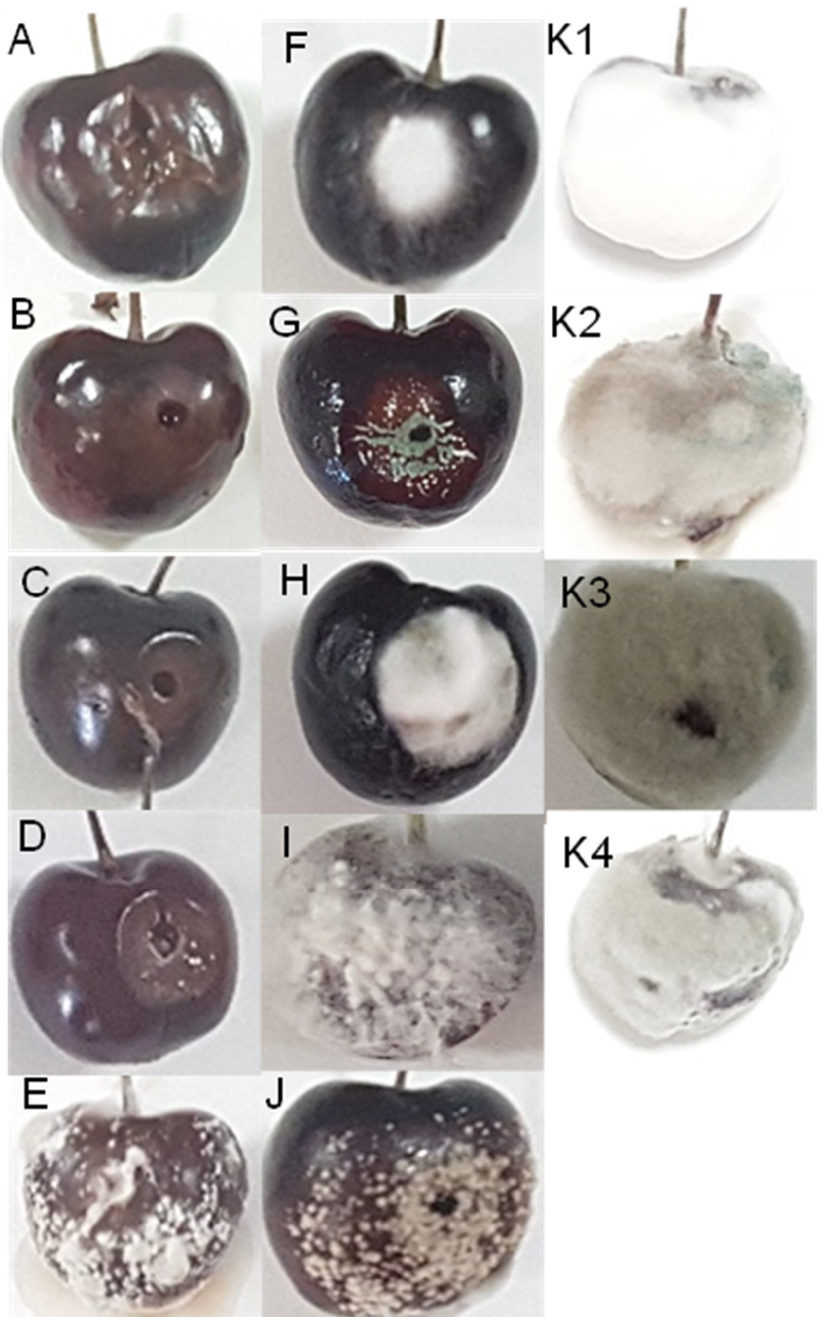
Figure 4. Cherries of the ‘Lapins’ cultivar inoculated with Lonsdalea quercina ( A ), Leuconoctoc mesenterioides ( B ), Hanseniaspora uvarum ( C ), Metschnikowia viticola ( D ), Geotrichum candidum ( E ), Fusarium oxysporum ( F ), Penicillium crustosum ( G ), Alternaria alternata ( H ), Schizophylum commune ( I ), Monilia laxa ( J ), and Botrytis cinerea isolates M2 ( K1 ), M15 ( K2 ), M31 ( K3 ), and M44 ( K4 ), stored at 25 °C for six days.